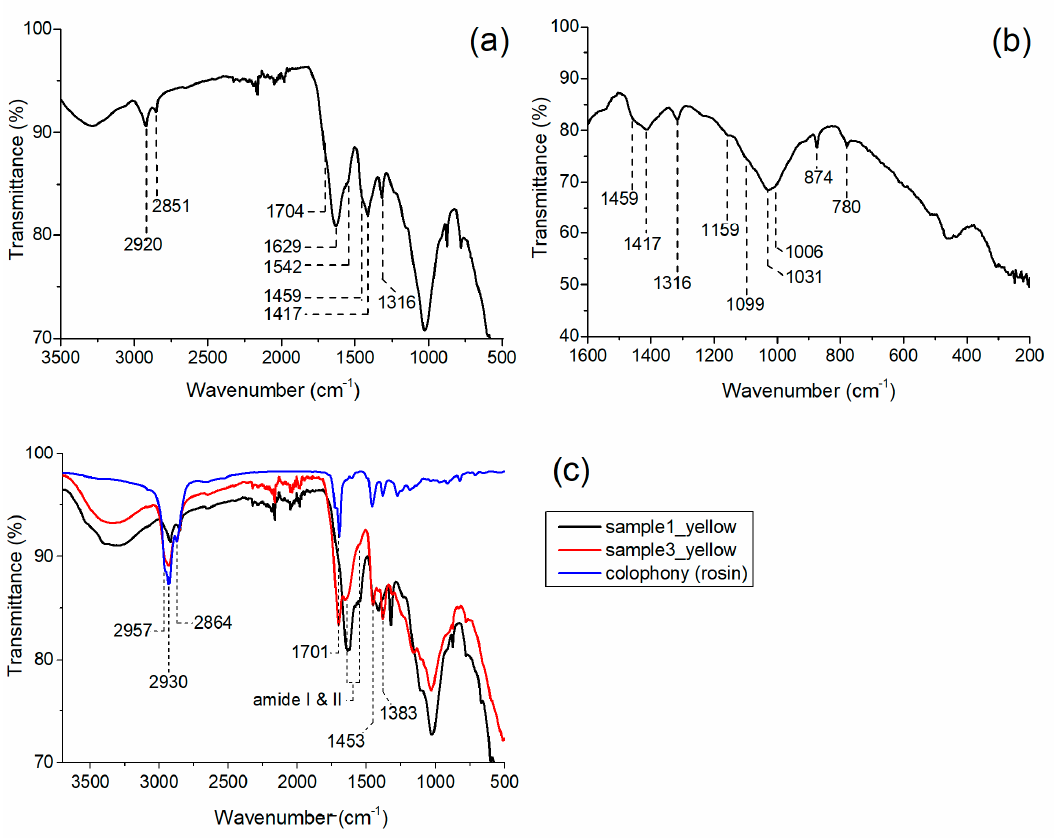
Figure 4. ATR-FTIR spectra of the gold varnish in the range 3500 ÷ 500 cm − 1 ( a ) and in the range, 1600 ÷ 200 cm − 1 ( b ), showing spectral features compatible with a mixture of proteins and oils. Comparison between the gold varnish from sample 1 and 3 with colophony reference spectrum ( c ), confirming its presence in sample 3.